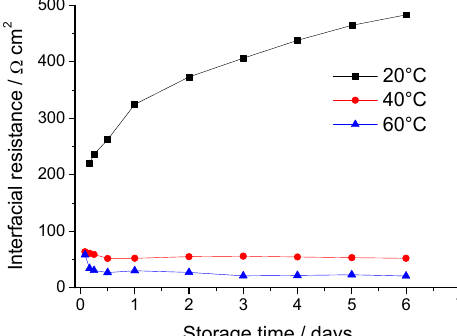
Figure 8. Evolution of the interfacial resistance of the cells at 20, 40 and 60 °C. Separator: Whatman